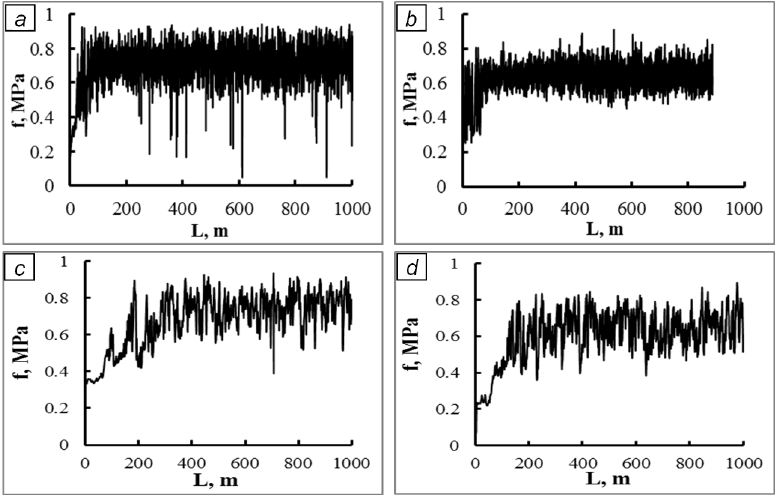
Figure 4. Effect of sliding distance on the value of the specific friction force of ECAP-ed Al-30Sn composite under dry friction against steel. Number of ECAP passes: ( a , c )—0 (sintered), ( b )—2, ( d )—4; P = 1 MPa; V sl , m/s: 0.07 ( a , b ) and 0.6 ( c , d